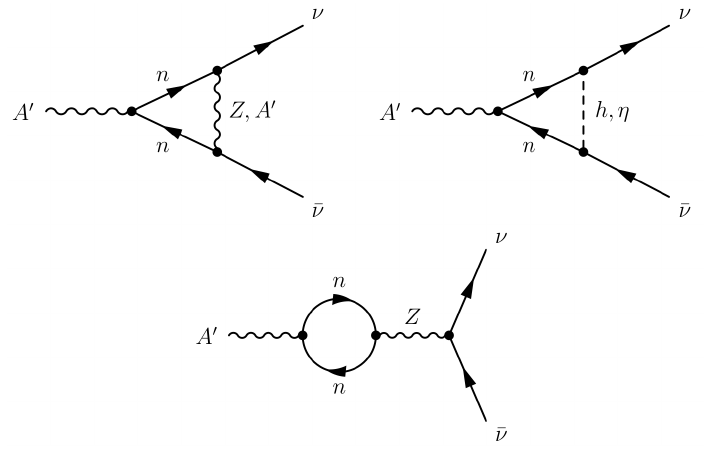
Figure 2 . The one-loop diagrams giving A 0 → ν ¯ ν decay. Here n = ν, χ 1 , 2 , N are mass